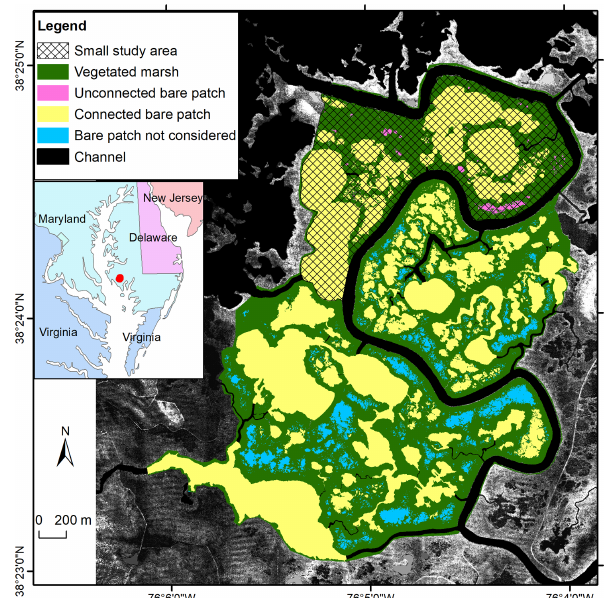
Figure 3. Study area in the Blackwater marshes. Spatial distribu- tion of vegetated marshes, unconnected bare patches, and connected bare patches in 2010 with lidar images as background. Data pre- sented in this paper are for all bare patches in the small study area – both unconnected ones (in pink) and connected ones (in yellow). In order to obtain a higher number of observations of connected bare patches, we also included connected bare patches in the larger study area (in yellow) but excluded unconnected bare patches (in